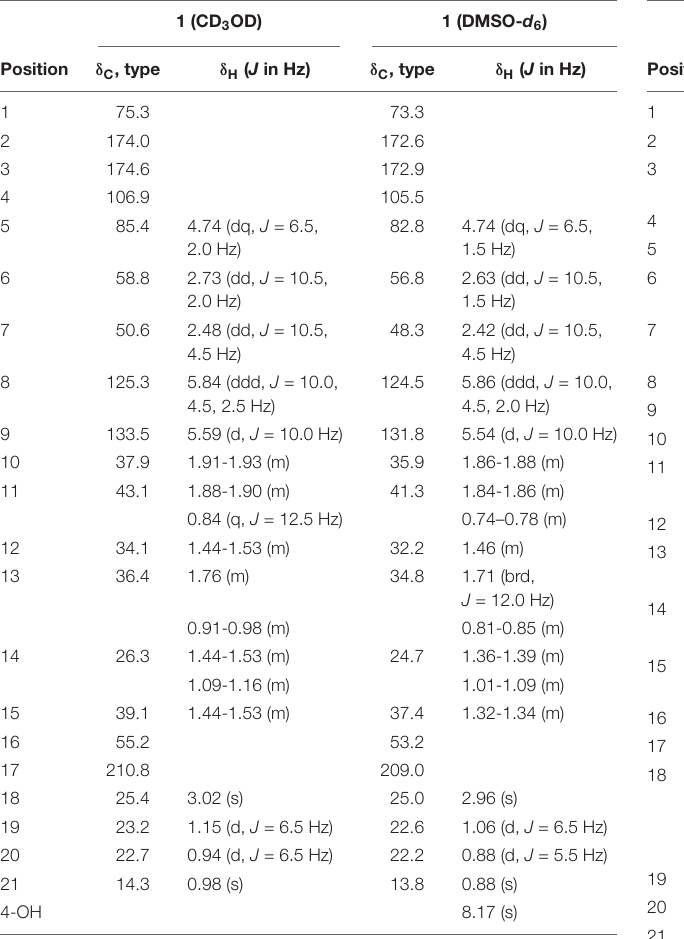
TABLE 2 | 1 H NMR Data (500 MHz, δ in ppm, J in Hz) and 13 C NMR Data (125 MHz, δ in ppm) for 2